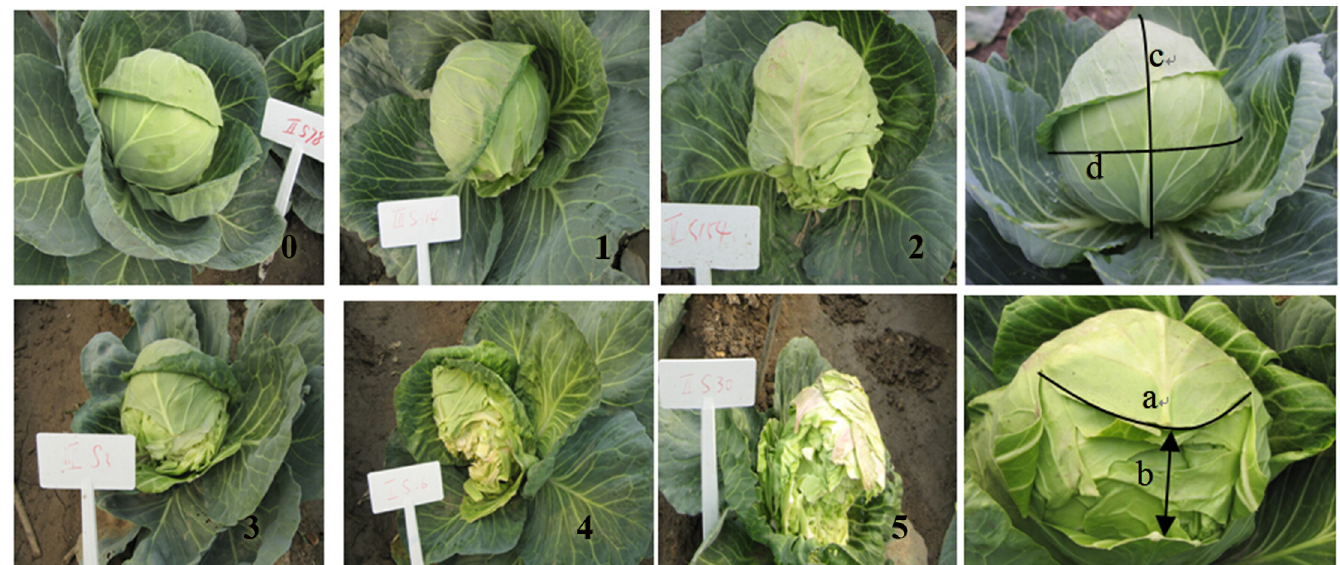
Fig 2. The grade 0 – 5 of head splitting resistance in DH population. 0 = no split; 1 = 1 split layer; 2 = 2 split layers and S < 50; 3 = 3 – 5 split layers and S < 50, or 2 split layers and S (cid:1) 50; 4 = 6 – 10 split layers and S < 50, or 3 – 5 split layers and S (cid:1) 50; 5 = more than 10 split layers, or 6 – 10 split layers and S (cid:1) 50. a = arc length and b = width of the largest split; c = height of the head and d = the largest circumference of the head. S [%] = S 1 /S 2 × 100%, where S 1 = a × b and S 2 = c × 1/2